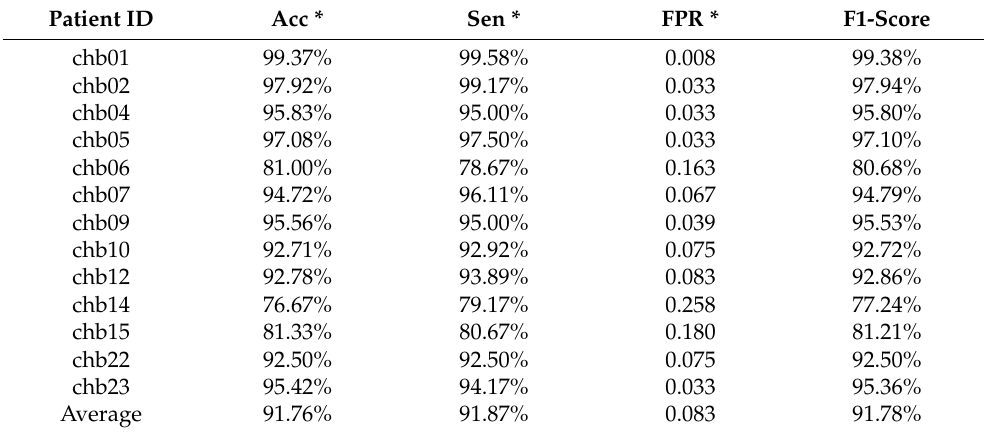
Table 2. Classification evaluation metrics (InT = 30 min).